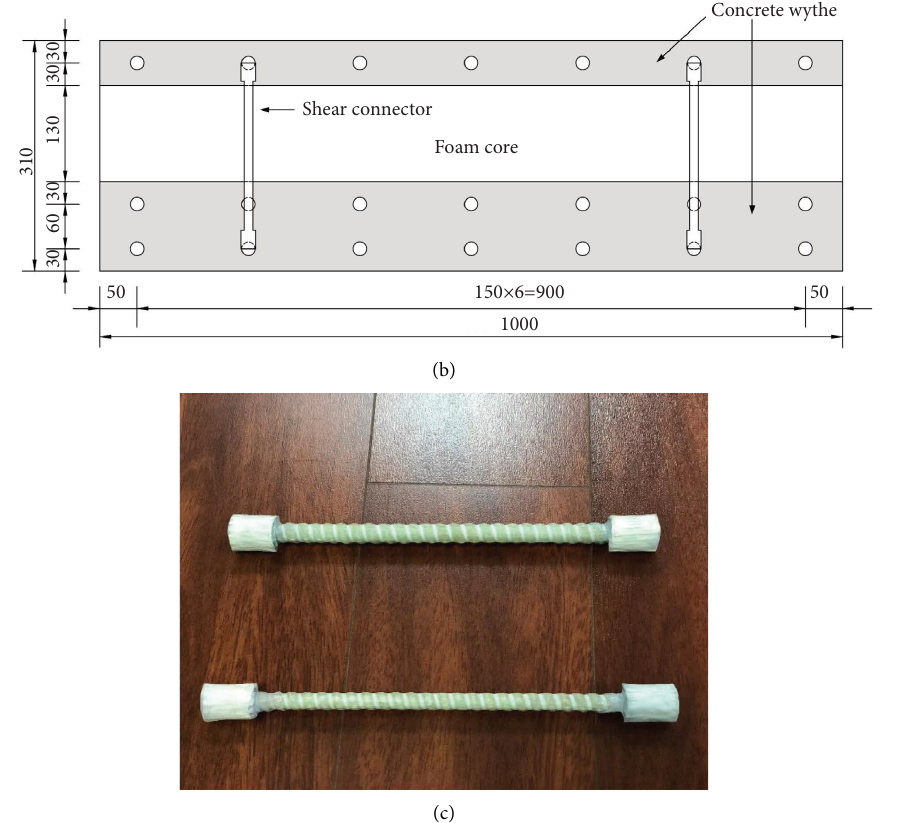
Figure 2: Te arrangement of the steel reinforcements and connectors (units: mm). (a) Top view of the sandwich panel. (b) Cross section of the sandwich panel. (c) Dumbbell-shaped SFCB